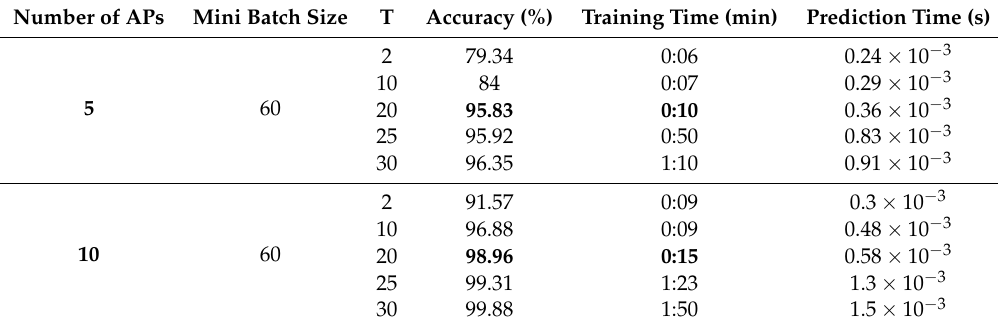
Table 5. Variation of the accuracy according to T using a grid of size 5 m × 5 m.